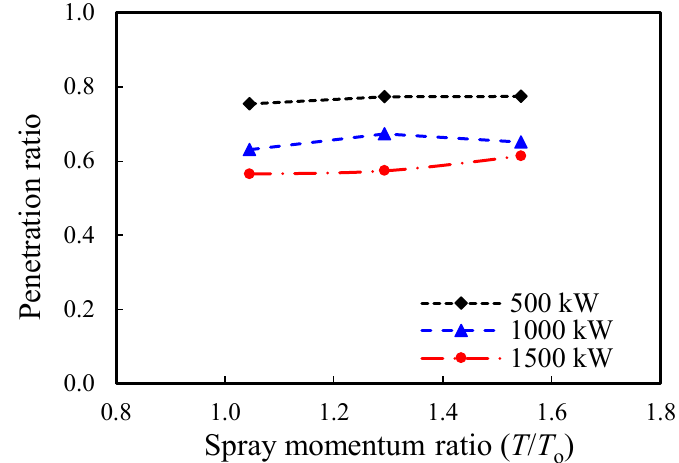
Figure 18. Spray moment effect at 3.161 L/s [73].